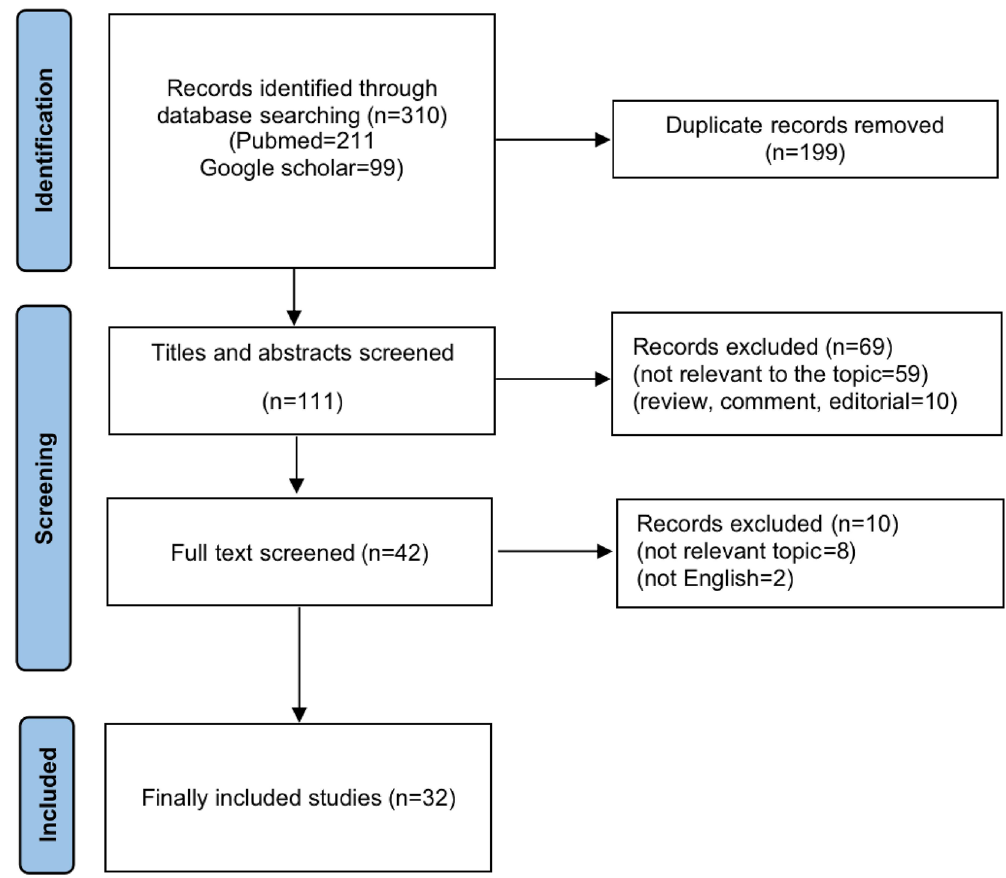
Figure 1. Flowchart of study selection for this